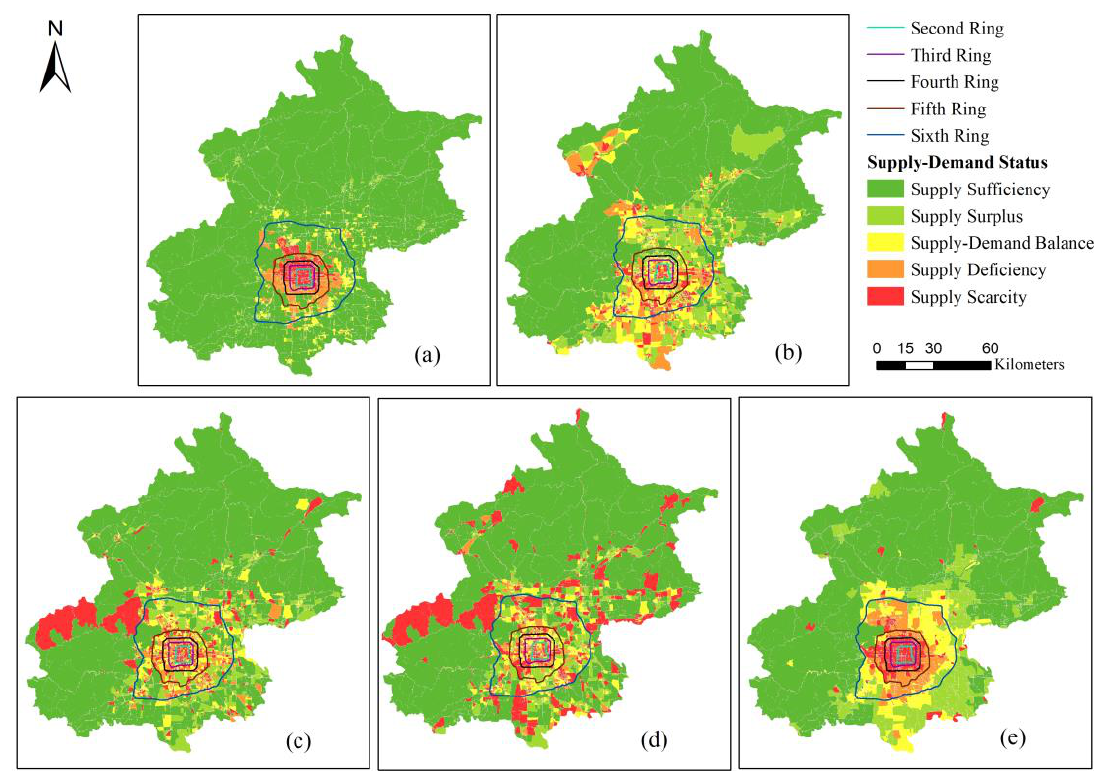
Figure 7. ESF supply–demand evaluation of ecology ( a ), landscape ( b ), disaster prevention ( c ), recreation ( d ) and culture ( e ).